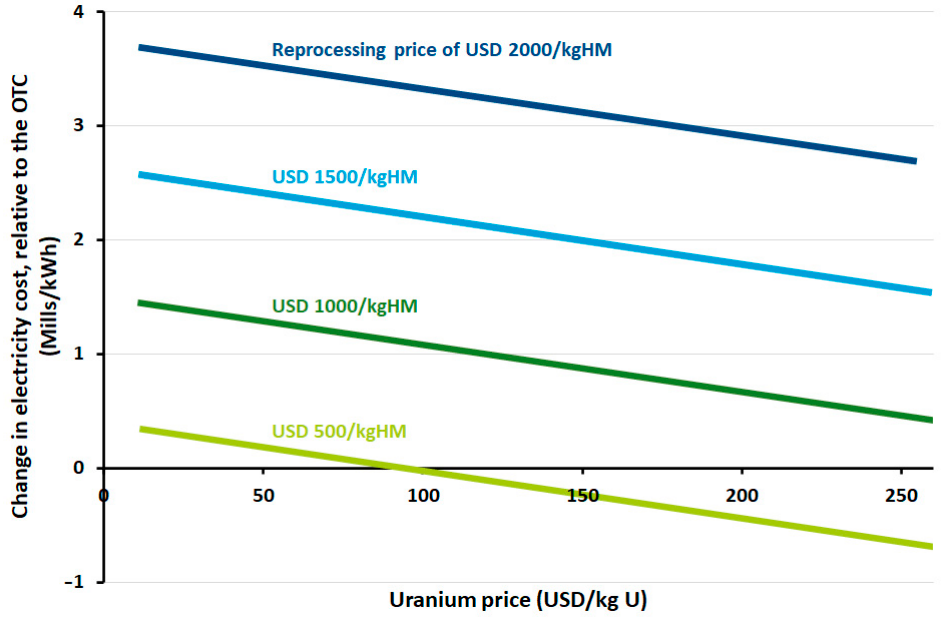
Figure 2. Additional cost of electricity for reprocessing and recycling of SNF (TTC) compared to the OTC for selected reprocessing costs as a function of the uranium price [55].